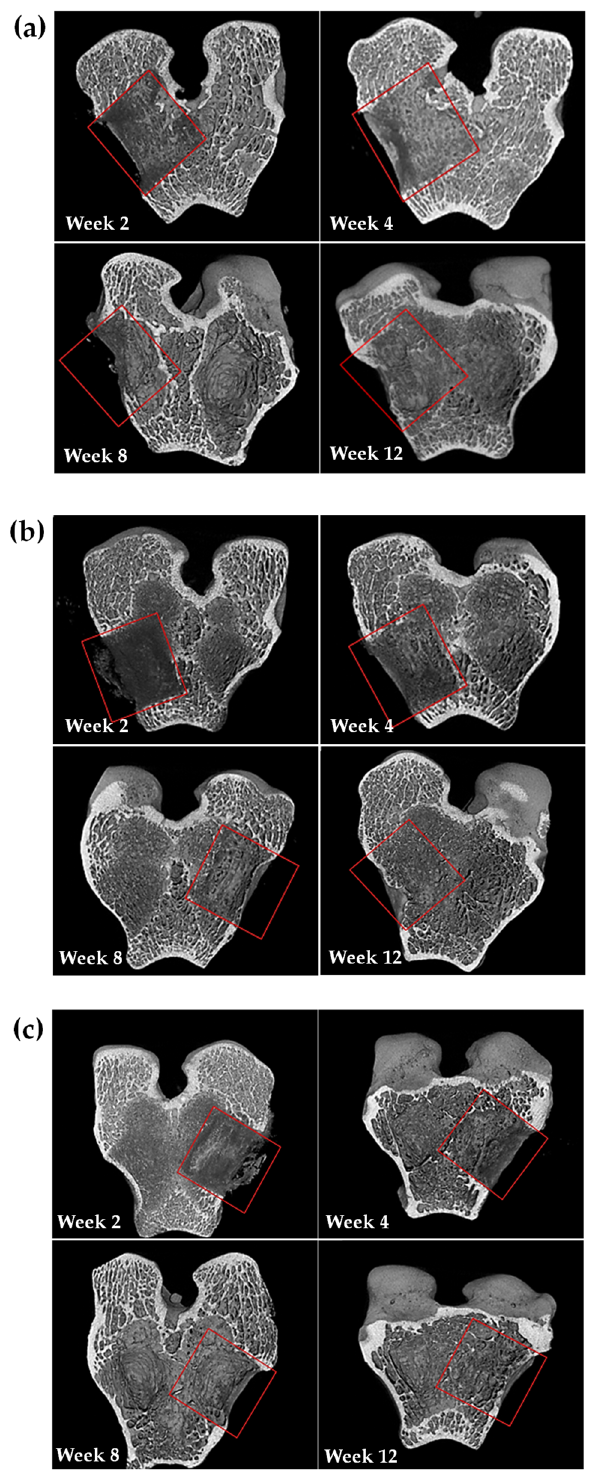
Figure 2. Micro-computed tomographic ( μ -CT images) showing the surgical area and the healing area of ( a ) blank, ( b ) control, and ( c ) α -CSH samples at each time point. Reference 1. Ou, K.L.; Hou P.J.; Huang, B.H.; Chou, H.H.; Yang, T.S.; Huang, C.F.; Ueno, T. Bone Healing and Regeneration Potential in